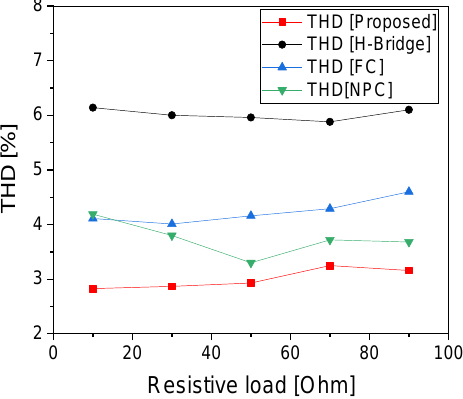
Figure 21. Comparison of THD vs. load with conventional rectifier.